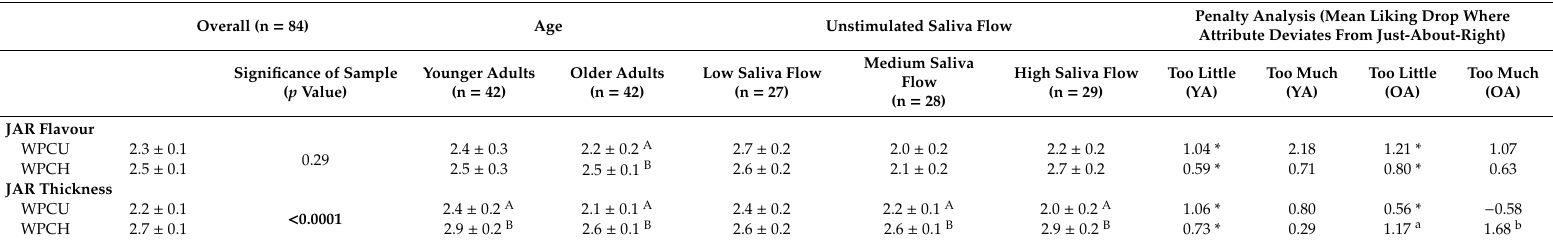
Table 5. Volunteers appropriateness of attribute level (Just-About-Right, JAR) mean ratings of whey protein beverages (WPB) and their influence on volunteer liking ratings; overall and by age (YA: younger adult and OA: older adult) and unstimulated saliva flow rate. Age Penalty Analysis (Mean Liking Drop Where Attribute Deviates From